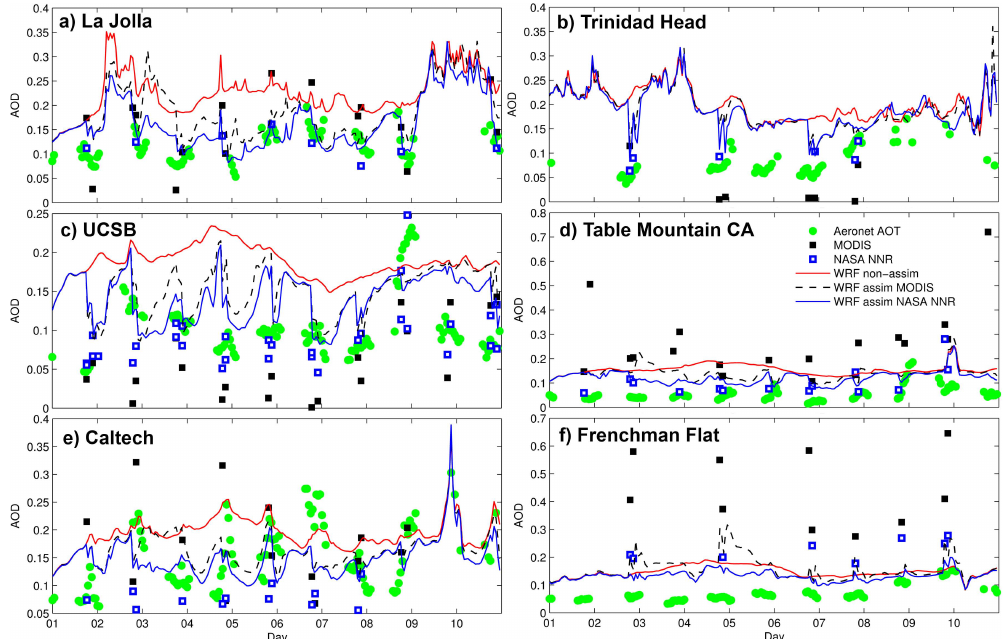
Fig. 6. AOD time series on a selection of sites for AERONET data (500nm), operational MODIS (550nm), NASA NNR (550nm), the non-assimilated forecast and the two assimilation forecasts (500nm). MODIS shows pixels lumped from Terra and Aqua, while NASA NNR shows pixels lumped for Terra, Aqua, land and ocean retrievals. For satellite data, the closest retrieval to the site is plotted only when the distance is less than 0.2 degree. See Fig. 1 for AERONET sites locations.